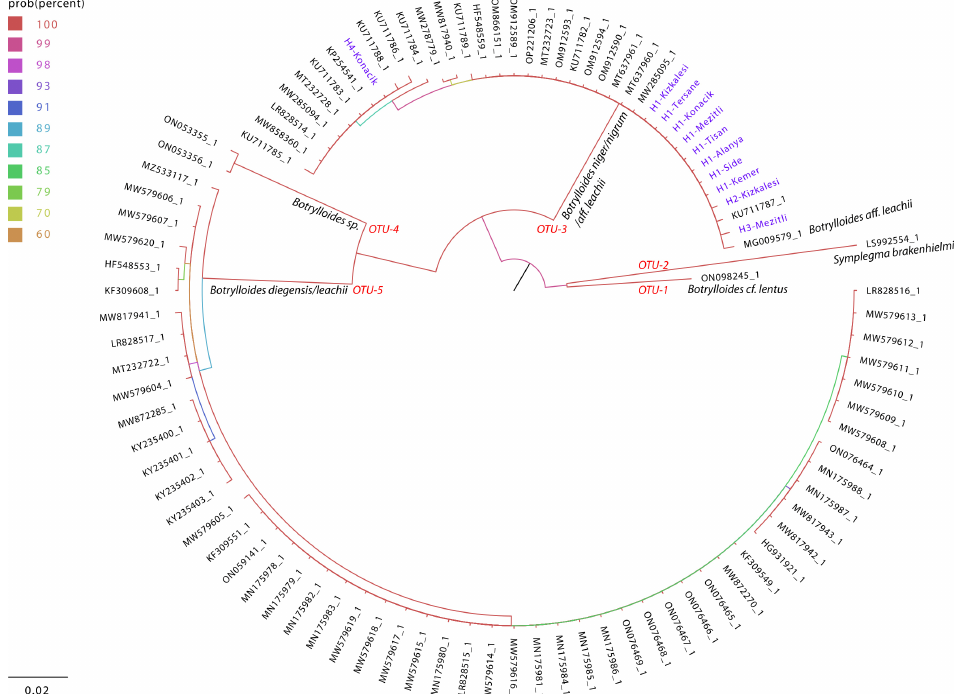
Figure 3. Bayesian majority rule consensus tree, reconstructed from the 519 bp COI sequence alignment. Support value is color-coded, as depicted on the left side of the tree. Corresponding OTUs, as determined by the ASAP and bPTP analyses, are written at the root of each group. The distance scale is given under the tree.